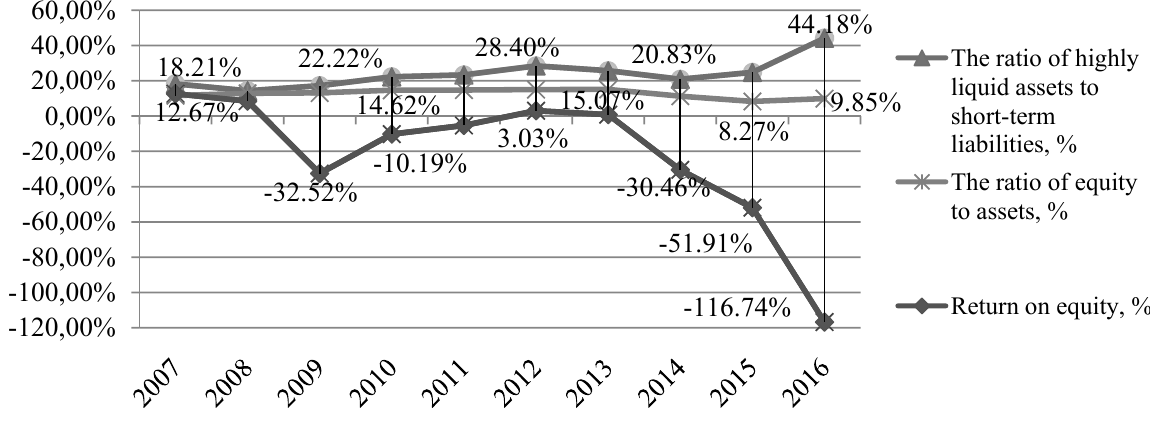
Fig. 1. Dynamics of basic factors that determine variations of capital stability of Ukrainian banks in the period of 2007–2016,